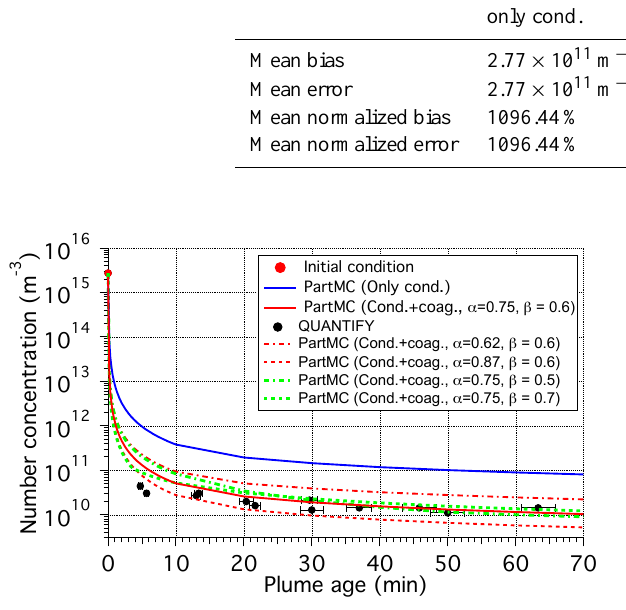
Figure 3. Comparison of modeled number concentrations from the base case with the measured data obtained during the single plume study on 14 June 2007 during the QUANTIFY campaign (size range of 10 to 2000nm). The red dot indicates the initial aerosol num- ber concentration. The horizontal error bars represent the estimated errors in determining plume ages. The four broken lines represent results from sensitivity runs with different sets of values for α and β